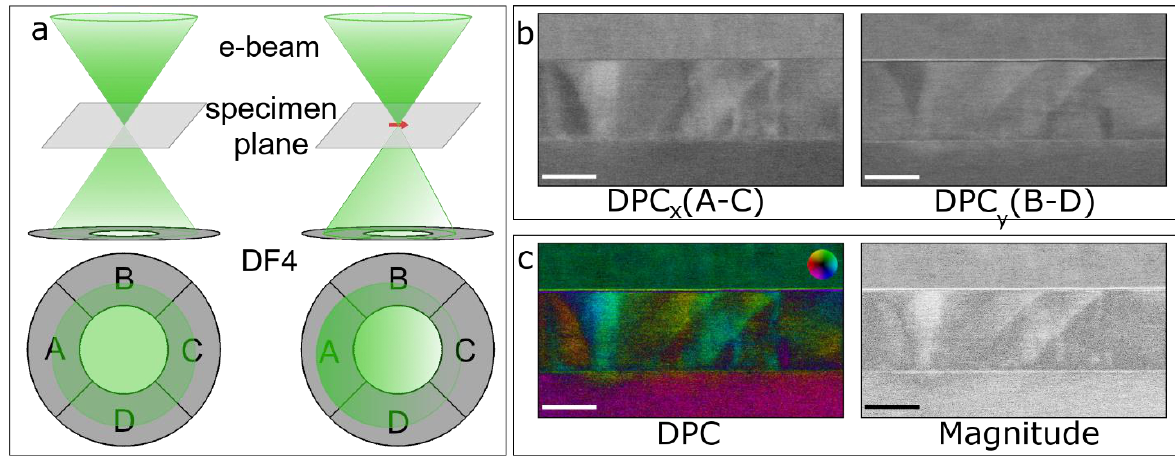
Figure 2. ( a ) Schematic representation of the basic principle of differential phase contrast (DPC)-STEM imaging. ( Left ) Electrons passing through vacuum. ( Right ) The electron beam is deflected by an electric field represented by the red ar-row. ( b ) Differential signals between two opposing detector segments (A − C, B − D). ( c ) Vector map of the DPC signal ( left ) and magnitude of the DPC signal ( right ). The scale bars are 50 nm.